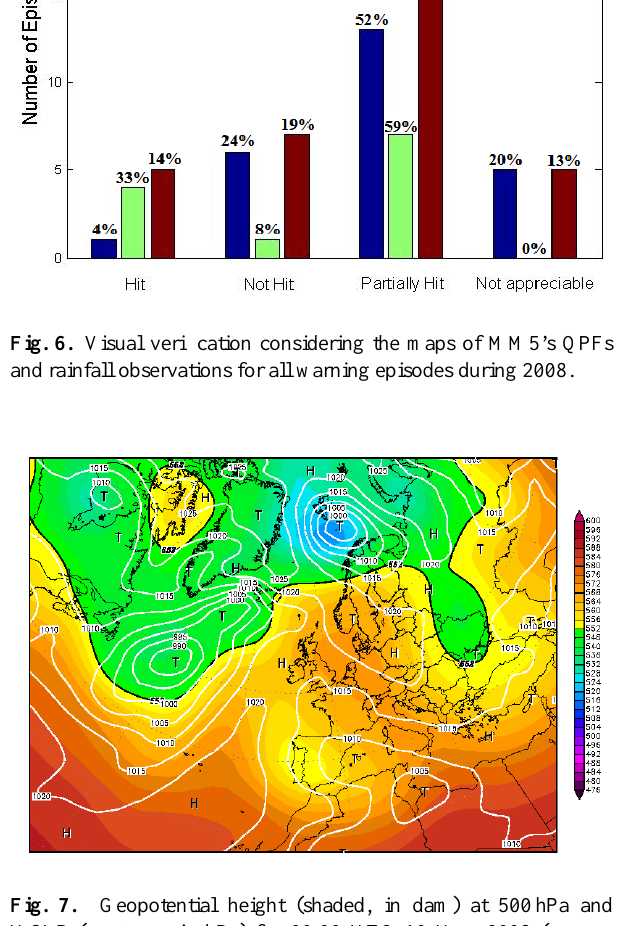
Fig. 7. Geopotential height (shaded, in dam) at 500hPa and MSLP (contours, in hPa) for 00:00 UTC 10 May 2008 (source: Figure 7. Geopotential height (shaded, in dam) at 500 hPa and MSLP (contours, in hPa) 3 for 00UTC 10 May 2008 (source: www.wetterzentrale.de). 4